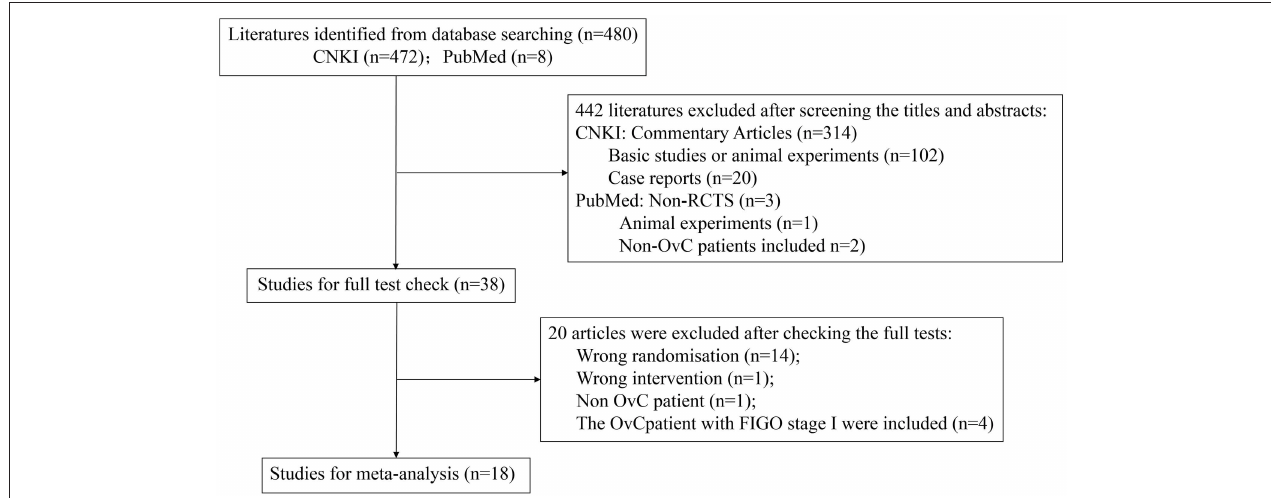
FIGURE 1 | Study inclusion and